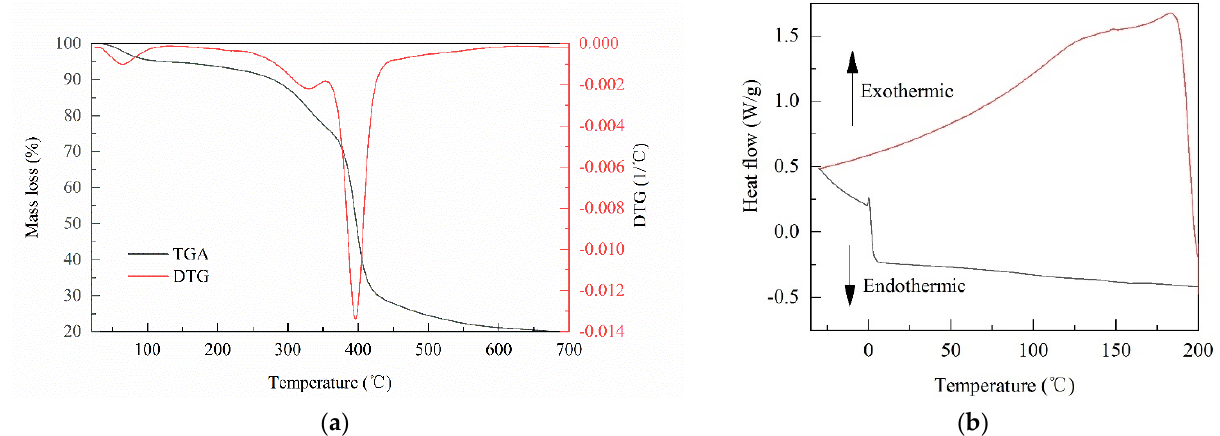
Figure 3. Thermal characterizations of PCB. ( a ) Thermogravimetric analysis (TGA) and differential thermogravimetric analysis (DTG) ramped profiles of the PCB ; and ( b ) differential scanning calorimetry (DSC) thermograms of the PCB.